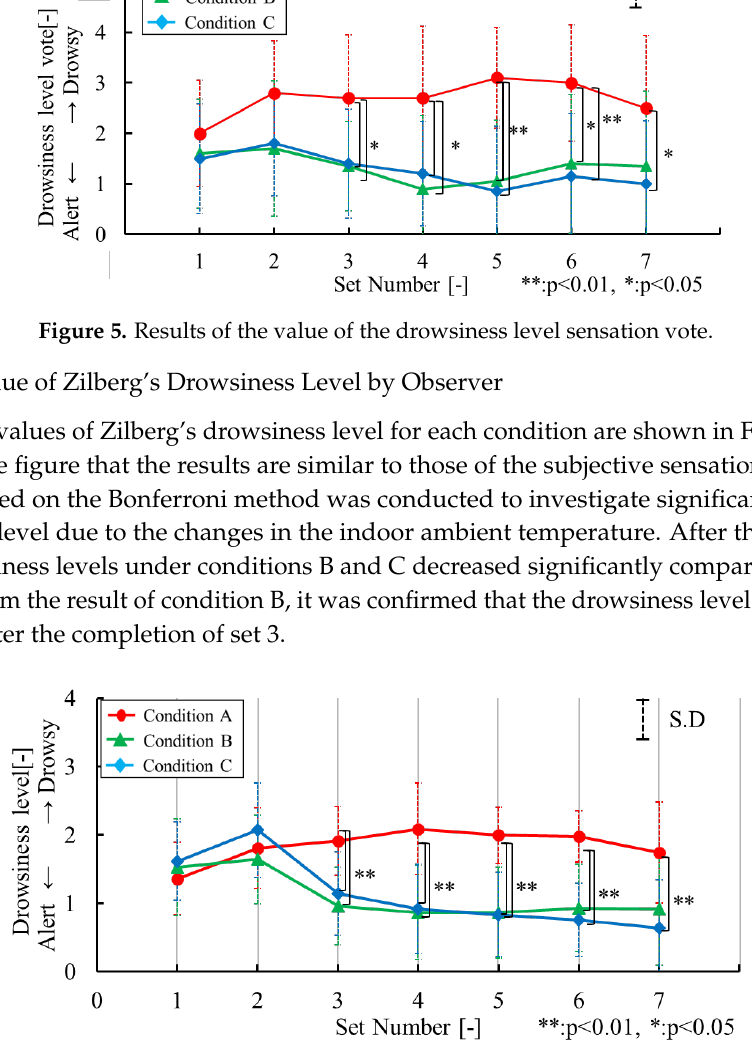
Figure 6. Drowsiness level reached when calculating MATH (analysis of facial expressions based on Zilberg’s method [20]).